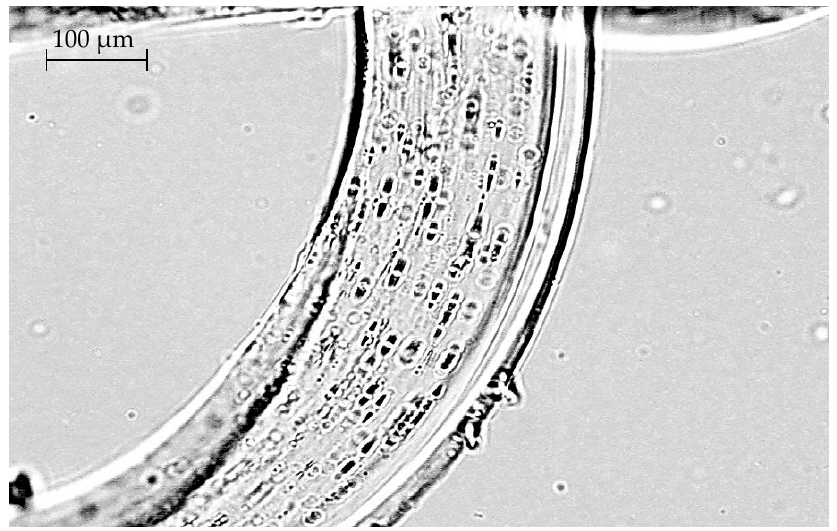
Figure 7. Cross section of a film with an extract concentration of 1% (63× magnification).